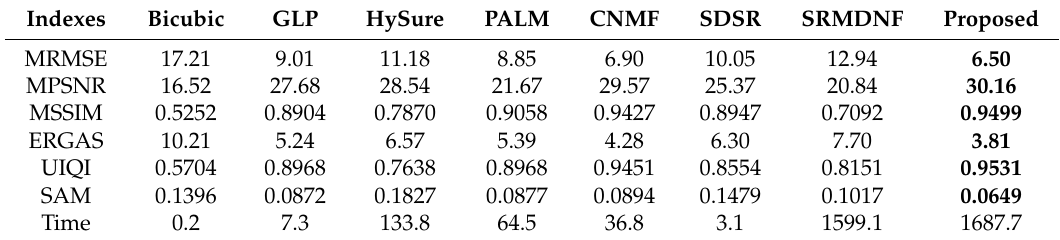
Table 7. Quantitative results on the Pavia dataset with a magnification factor of 4.